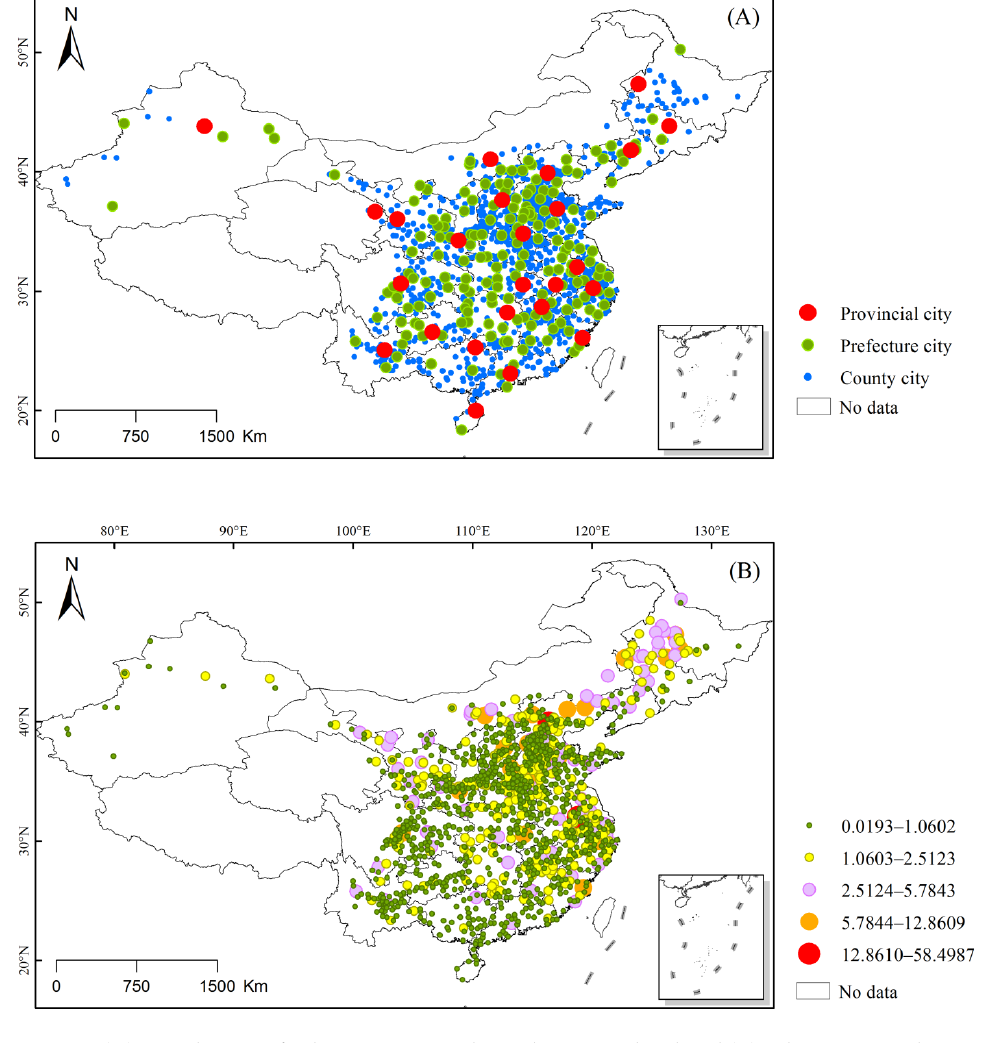
Figure 4. ( A ) Distribution of urban areas at or above the county level and ( B ) urban areas in the TCE. The data were classified using the Jenks natural breaks method.